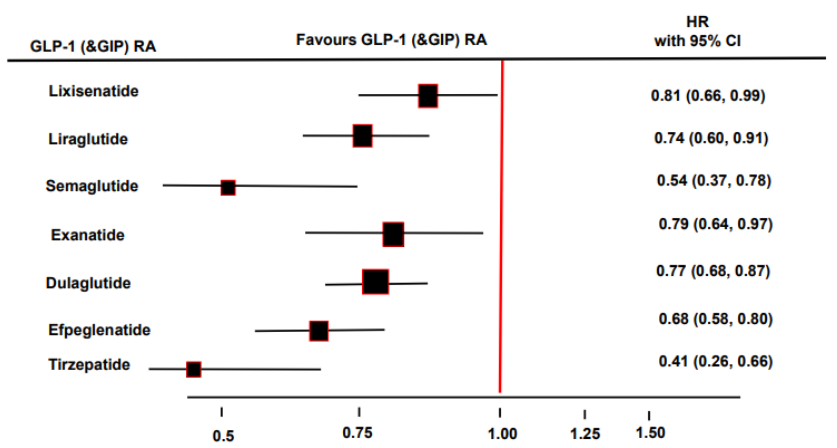
Figure 3. Single glucagon-like peptide 1 (GLP-1) and dual GLP-1 and glucose-dependent insulinotropic polypeptide (GIP) receptor agonists (RA) effects on macroalbuminuria [35,36,41,91,98–100]. Activation of a proinflammatory state, increased production of advanced glycation end products (AGEs), and enhancement of oxidative stress are all disturbances connected with hyperglycemia and metabolic changes typical of diabetes. However, inflammation is also an underlying condition in the development of diabetic nephropathy [12]. Apoptosis of podocytes in the kidney related to proteinuria and glomerulosclerosis is induced by higher levels of proinflammatory advanced oxidation protein products (AOPPs), which are increased in patients with diabetes [98]. AOPPs are related to diabetic nephropathy by promoting the production of several other proinflammatory factors, such as nicotinamide